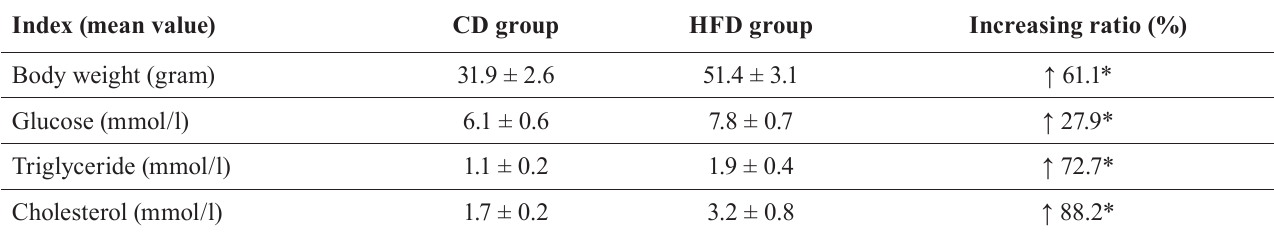
TABLE I - T he change in the biochemical index of mice groups after 8 weeks Index (mean